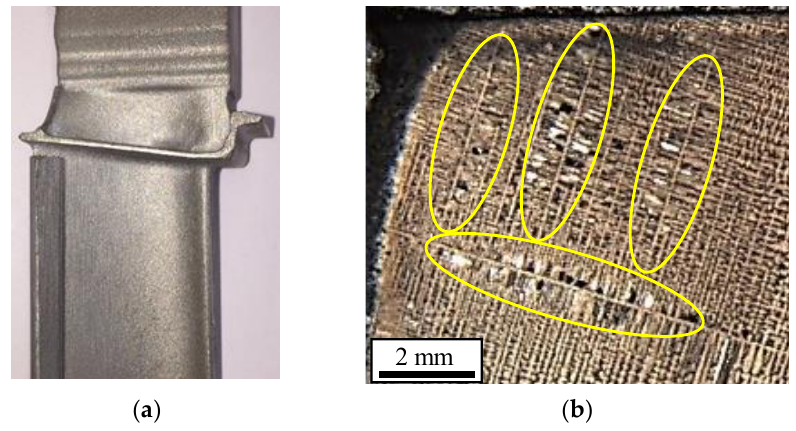
Figure 9. ( a ) Typical photo of the etched CMSX-6 blade, and ( b ) the cross-section of the platform extremity showing fragmentation of dendrite arms.